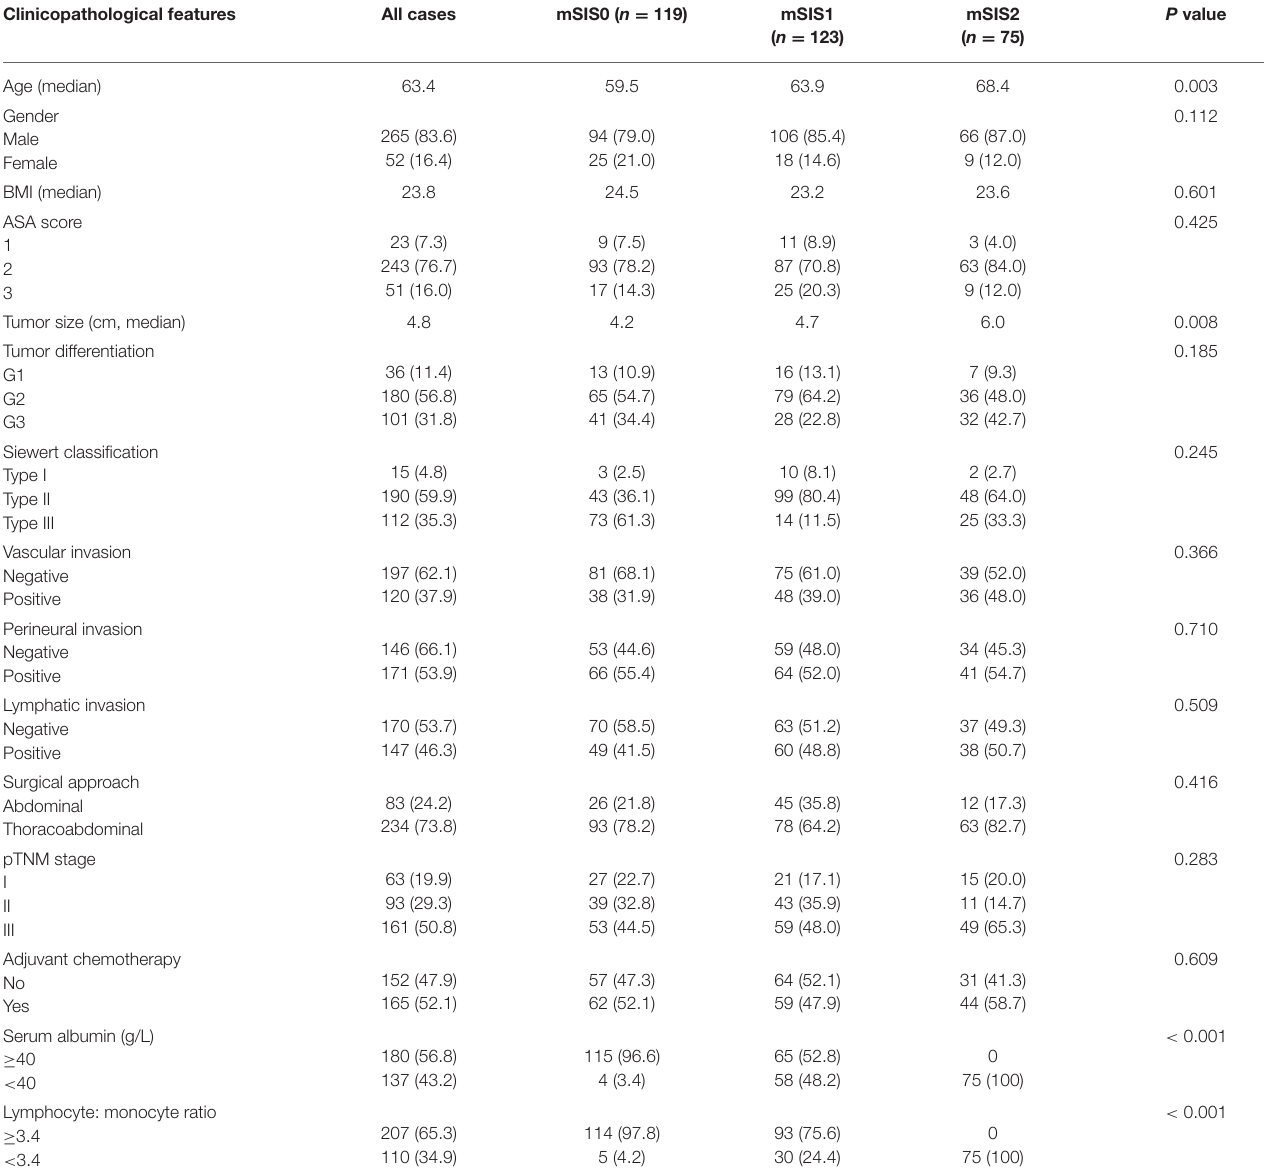
TABLE 1 | Association of mSIS and clinicopathological characteristics in patients with AEJ. Clinicopathological